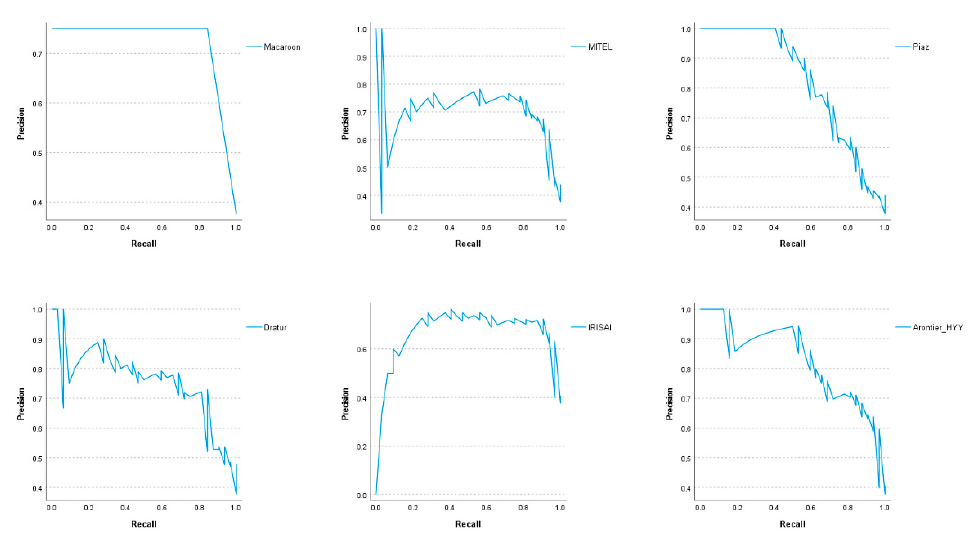
Figure 11. Precision–recall curves for the methods proposed by the six best teams in the subset of equivocal cases by IHC (score of 2+).